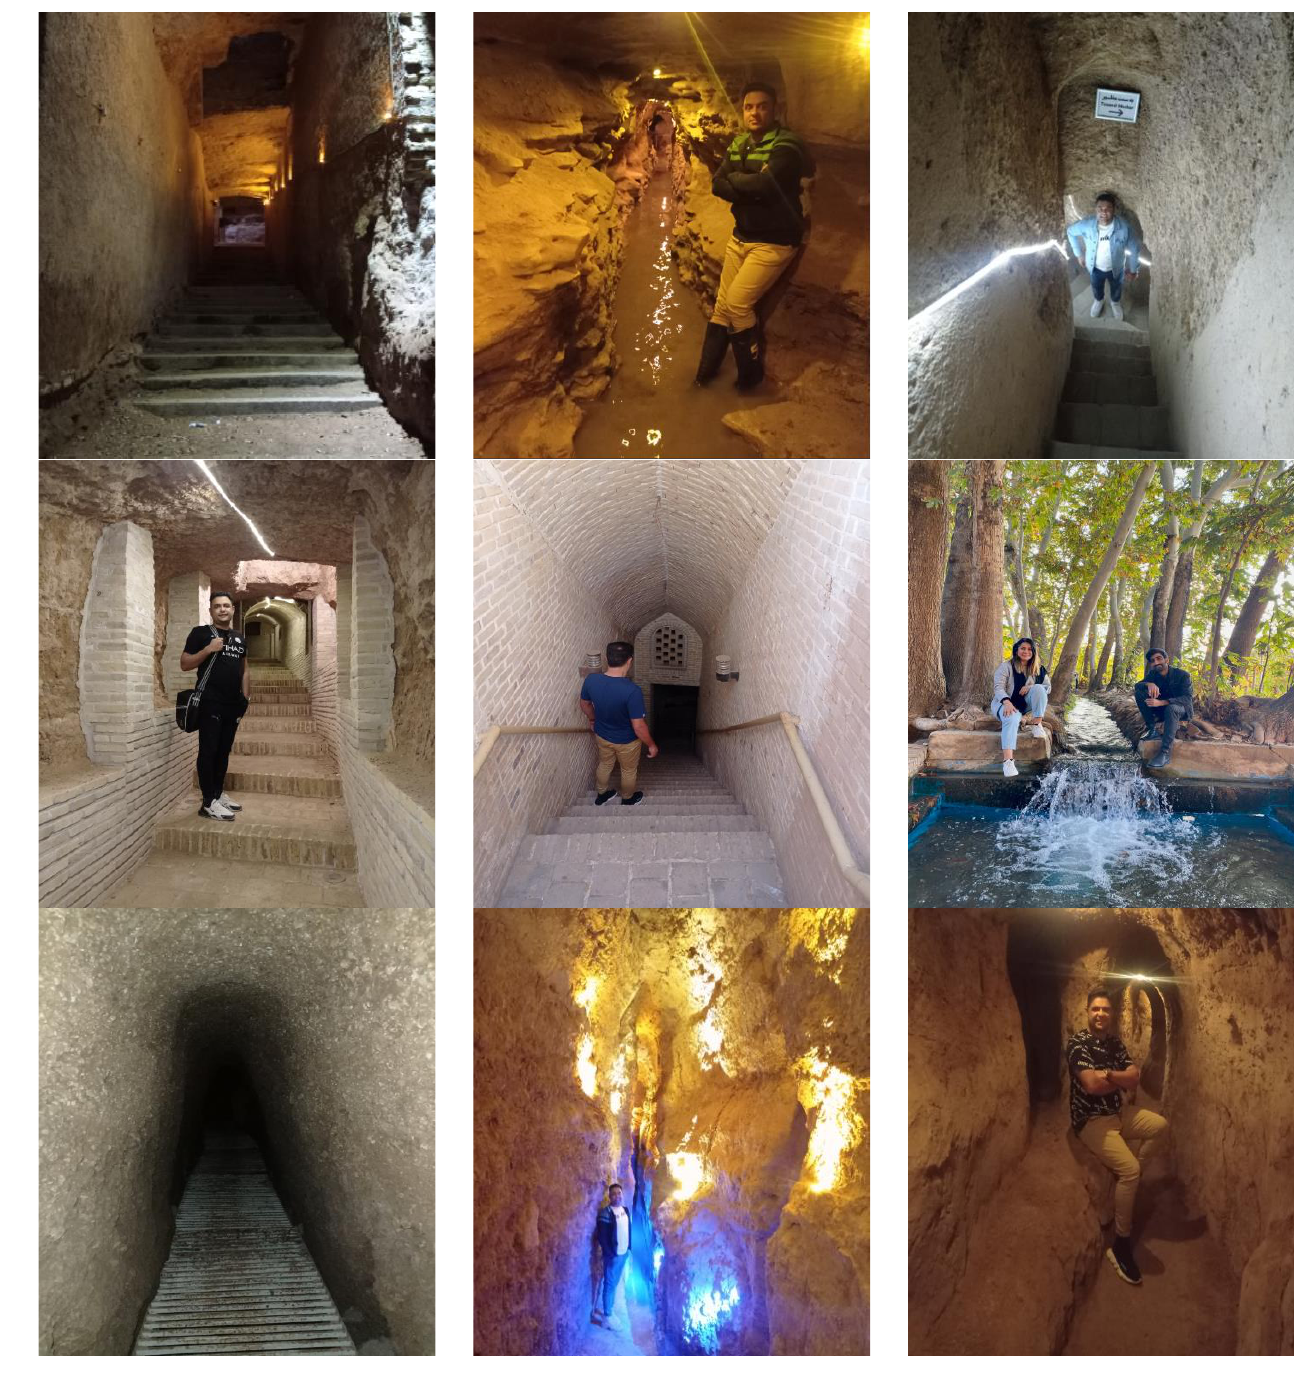
Figure 3. Tourism routes in